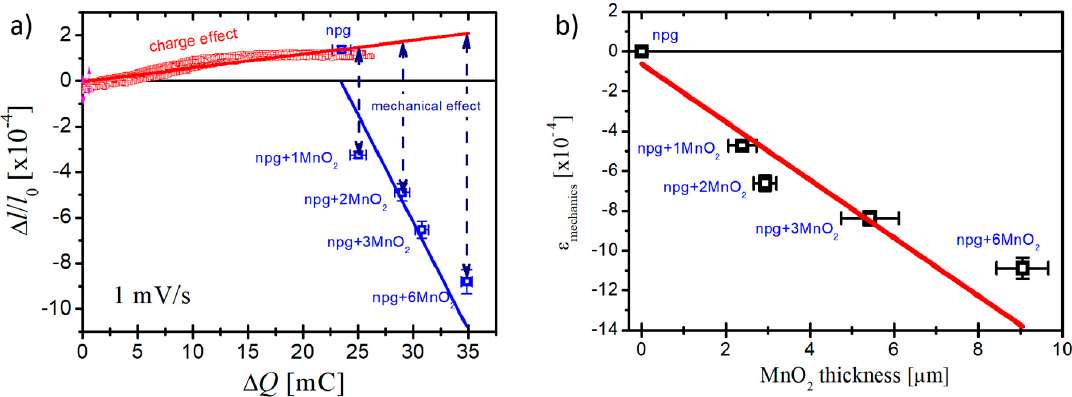
Figure 5. The actuation response of different samples as the function of the charge change ( a ) and the mechanical effect of MnO 2 on the actuation behavior of nanoporous gold ( b ).